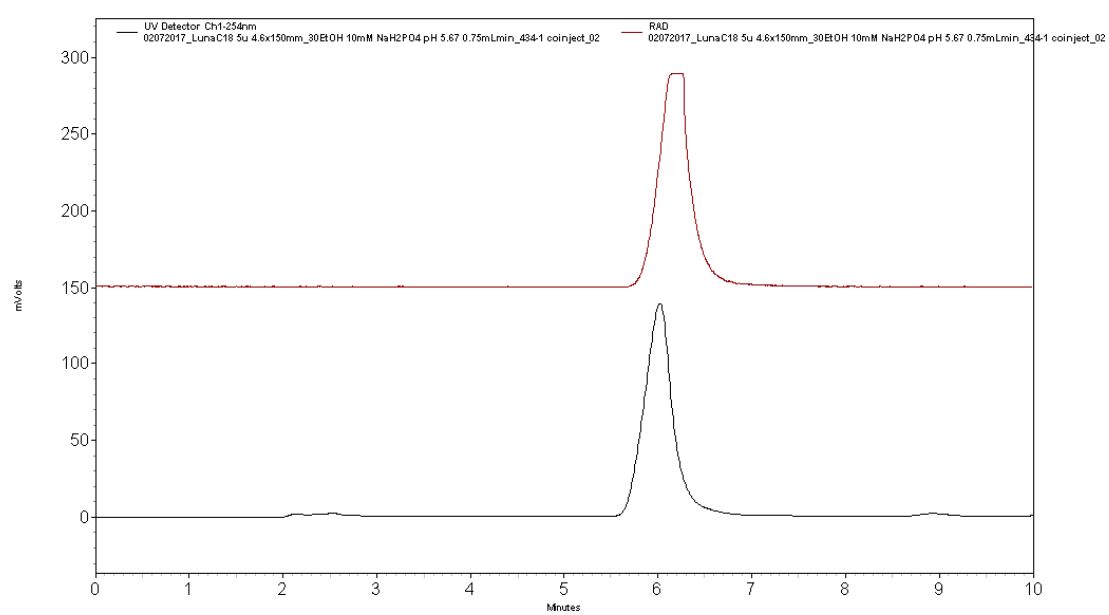
Figure 6. Analytical HPLC trace for formulated [ 11 C]AZ683 dose co-injected with AZ683 reference standard 6a.